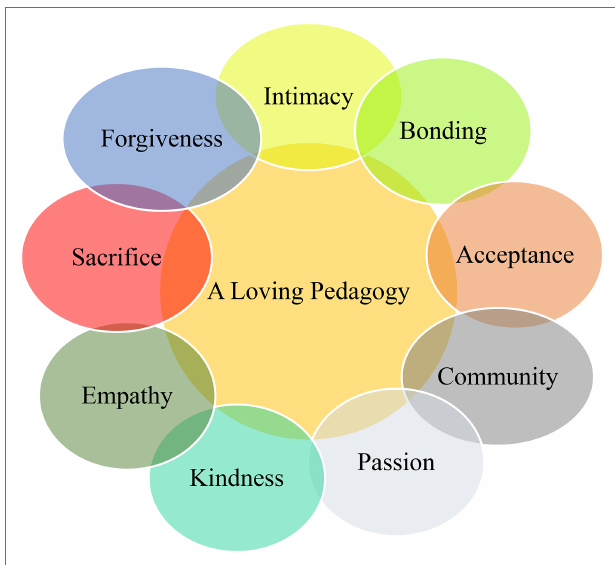
FIGURE 2 | Nine concepts constituting a loving